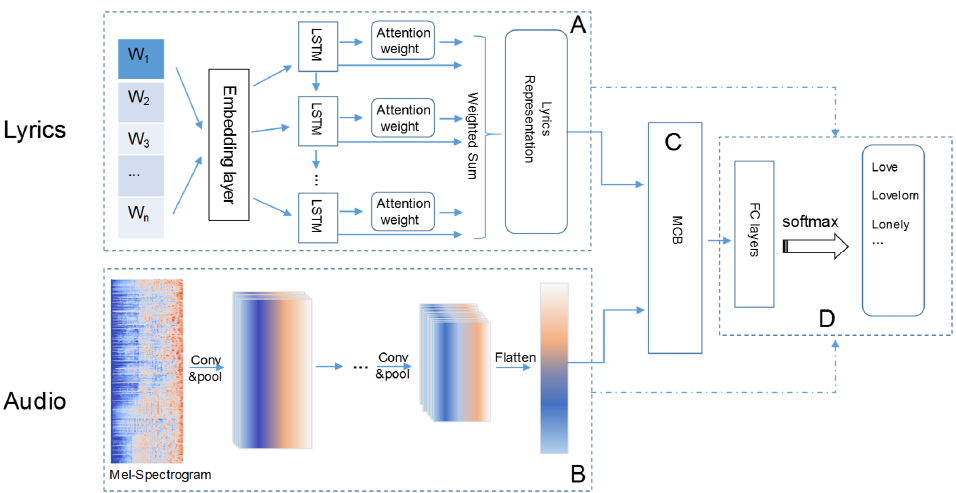
Figure 1. Model for bimodal representation learning between song audio and lyrics for emotion classification. The model includes four main modules: module A : the attention-based Long Short-Term Memory (LSTM) for extracting lyric features; module B : the proposed Convolutional Neural Network (CNN) for extracting audio features; module C : concatenating extracted audio and lyrics features by multimodal compact bilinear pooling; module D : determining song emotion by Fully-Connected (FC) layers and